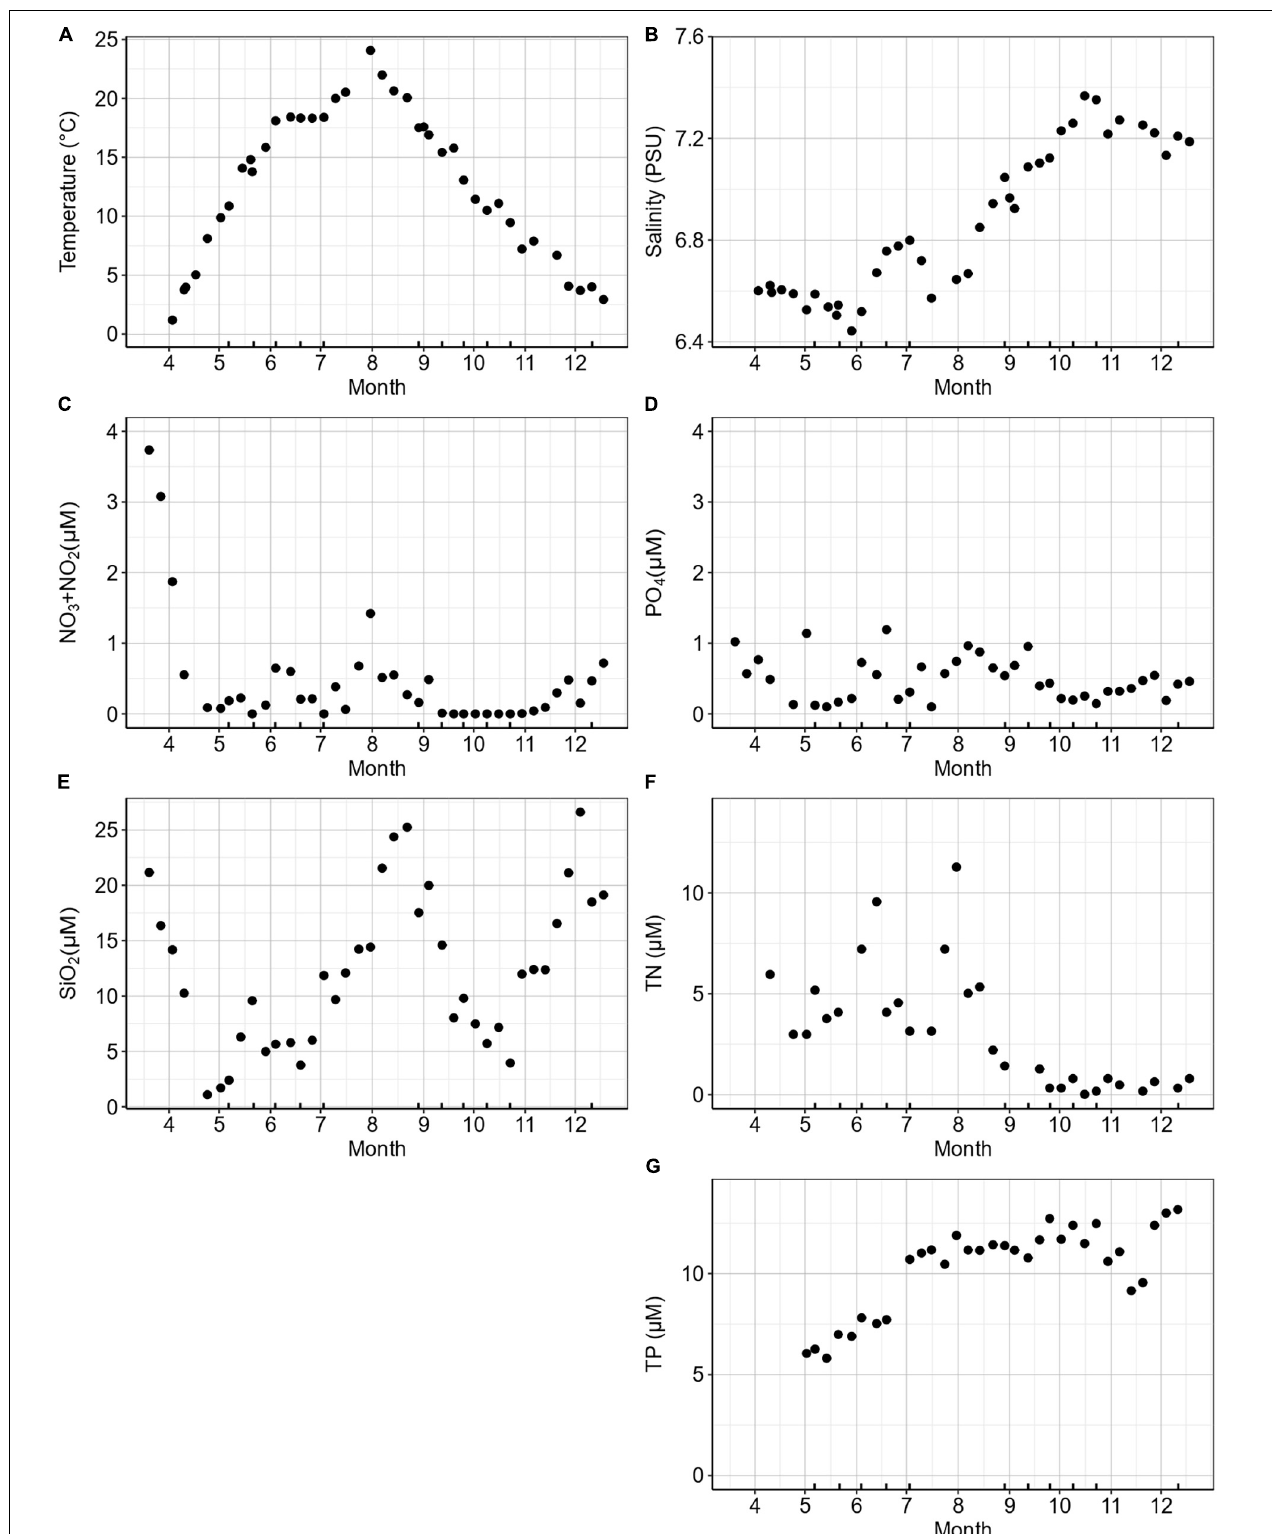
FIGURE 1 | K-station weekly measurements during 2018 for (A) temperature ( ◦ C), (B) salinity (PSU), (C) NO 2 + NO 3 ( µ M), (D) PO 4 ( µ M), (E) SiO 2 ( µ M), (F) total N (TN; µ M), and (G) total P (TP; µ M). Ticks on the x -axis mark the dates when a bioassay was performed.